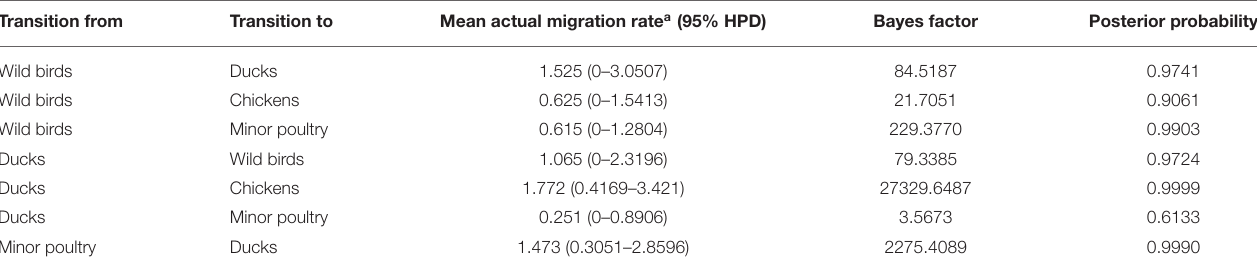
TABLE 3 | Viral transition of discrete traits (based on HA gene sequences) between different host species (ducks, wild birds, chickens, minor poultry) in South Korea. Transition